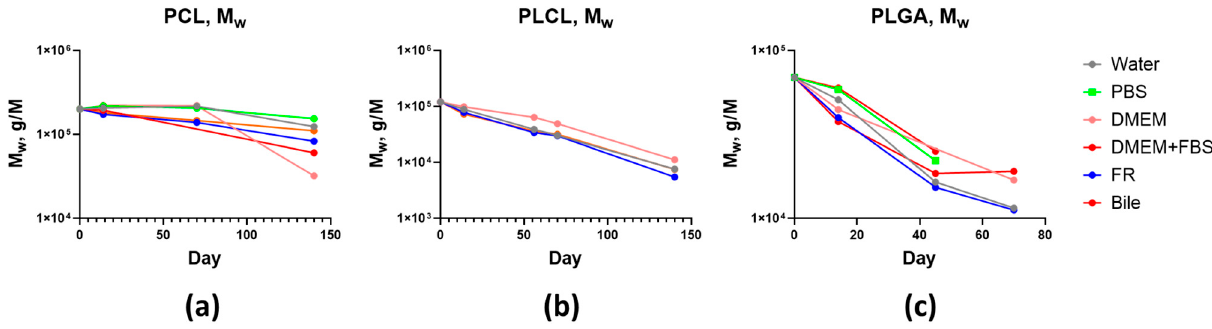
Figure 3. Decrease in the molecular mass of scaffolds based on: ( a ) PCL; ( b ) PLCL; ( c ) PLGA. It is evident that molecular mass loss is accelerated with time. The self-catalyzed character of destruction is determined by the accumulation of acid released during the degra- dation of polyester bonds. Let us consider the effect of the test medium on the decrease of